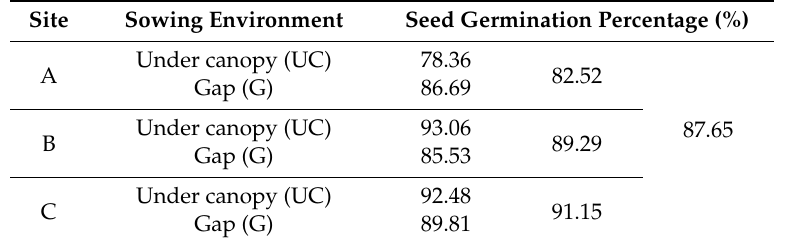
Table 5. Seed germination percentages from the early sowing period (ESP–December).